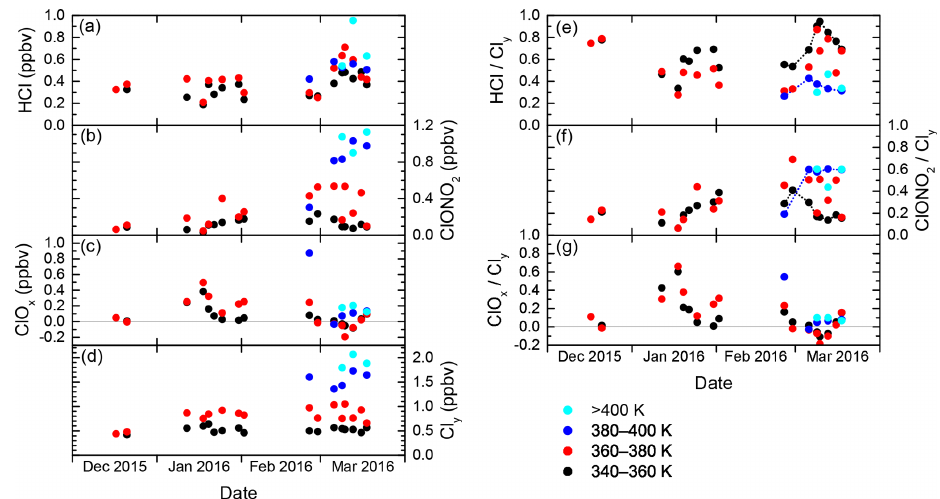
Figure 6. Daily averages of measured mixing ratios of HCl, ClONO 2 , ClO x and Cl y throughout the winter 2015/2016, from data that have been labelled “intra-vortex”. (a–d) Absolute mixing ratios. Colours are the same as in Fig. 5. (e–g) Similar to (a) – (d) , but for relative contributions of HCl, ClONO 2 and ClO x to Cl y . Some of the black and blue points are connected by dashed lines to guide the eye along the different deactivation